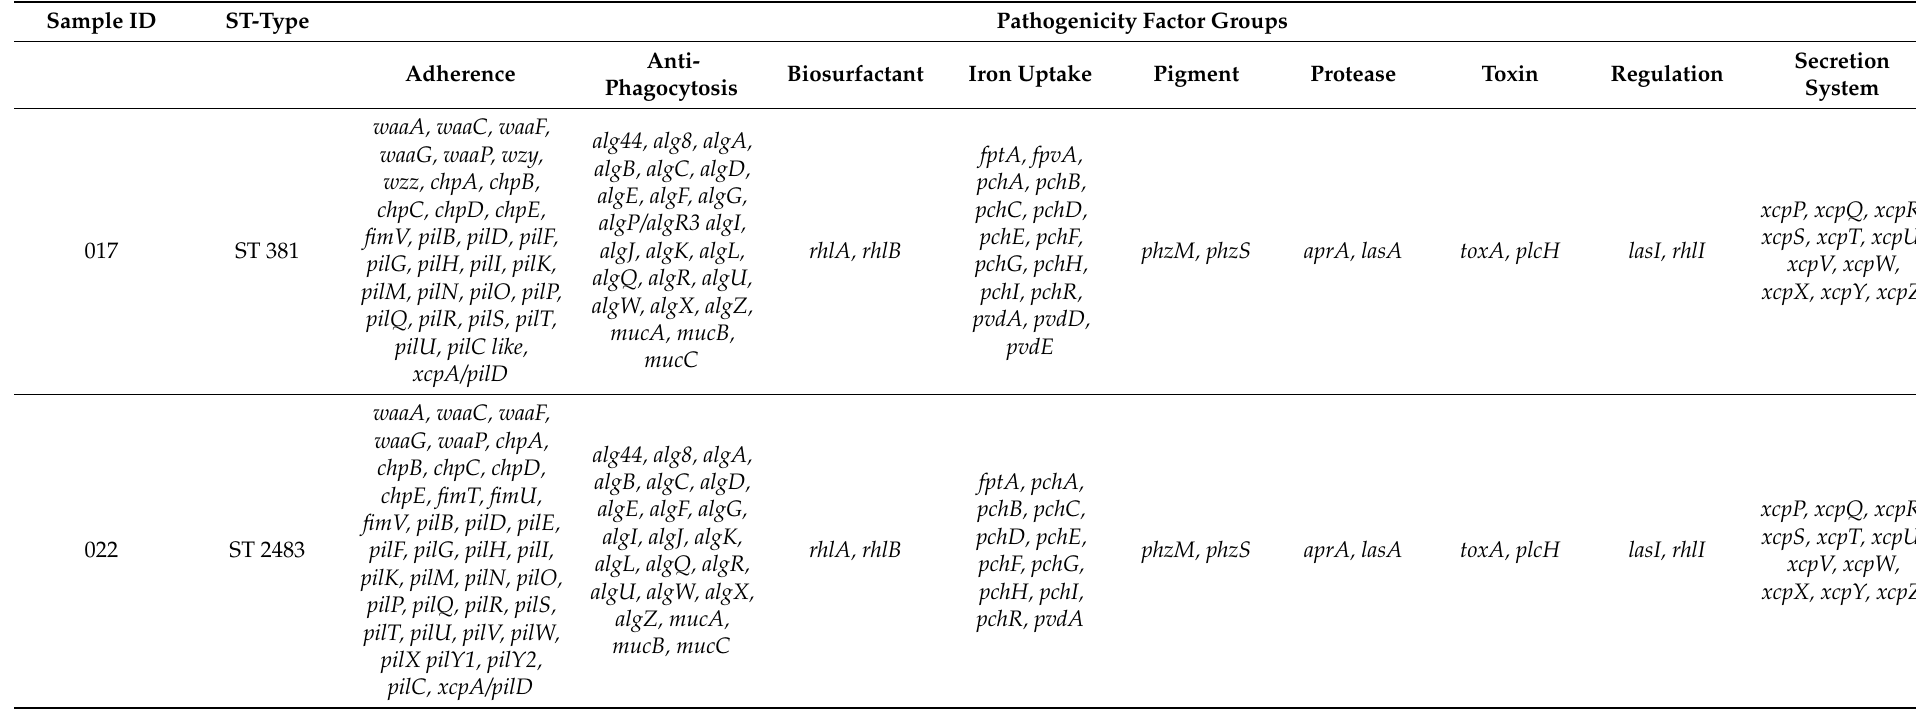
Table A9. Analysis of virulence determinants, ordered by strain and MLST type, of the assessed P. aeruginosa isolates. ST = Sequence